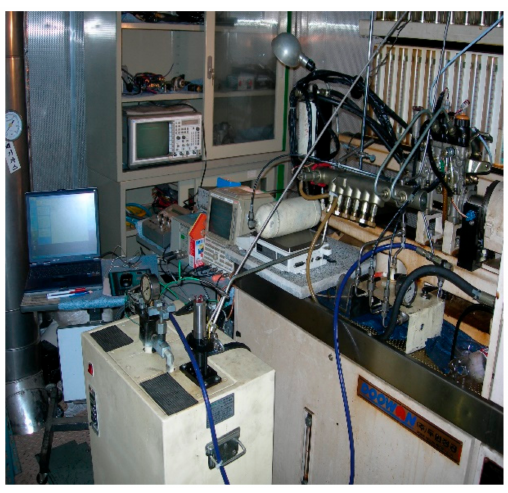
Figure 1. Photograph of common rail injection system and test